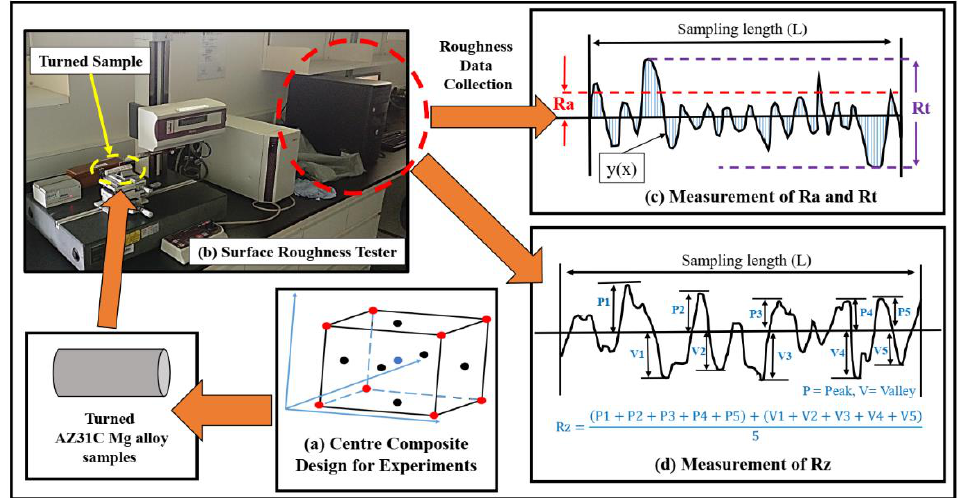
Figure 2. An overview of the surface roughness analysis approach and surface roughness parameters utilized in the study.